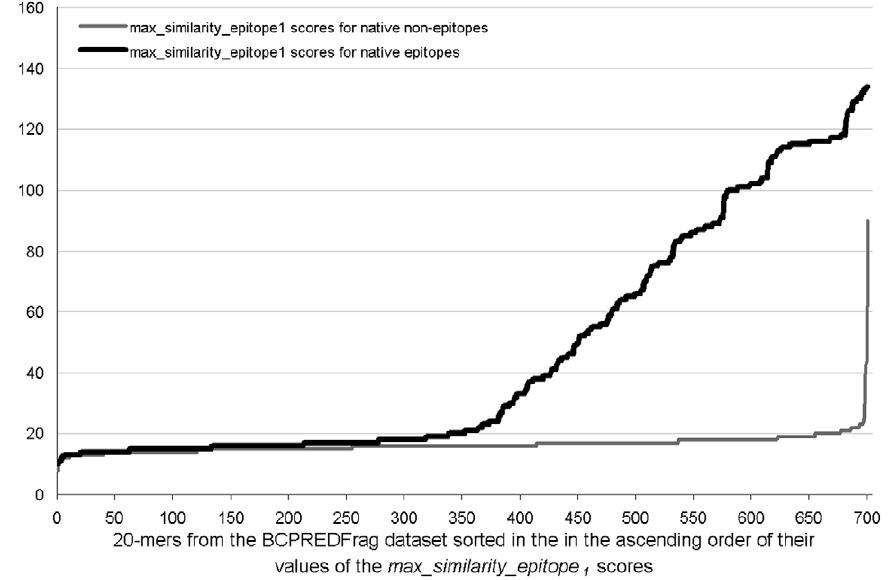
Figure 3. The values of the similarity-based scores between the 20-mers from the BCPREDFrag dataset and the library of the epitope fragments, i.e., the max_similarity_epitope 1 feature. The black line shows the similarity scores for the native epitope and the gray line for the non-epitope fragments. The x -axis corresponds to the sorted list (in the ascending order based on the similarity scores) of the 701 epitopic and 701 non-epitopic 20-mers from the BCPREDFrag dataset, and the y -axis shows their corresponding similarity scores.